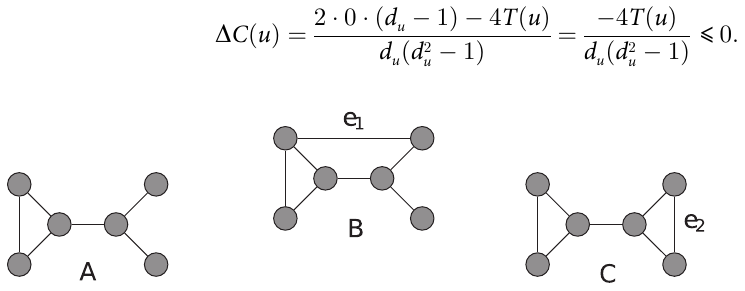
Fig 2. Varying effects of adding a link to a network on the clustering coefficient. (a) Original network with clustering coefficient C ¼ 0 : 3�8 . (b) Network after connecting two nodes with no common neighbours, C G